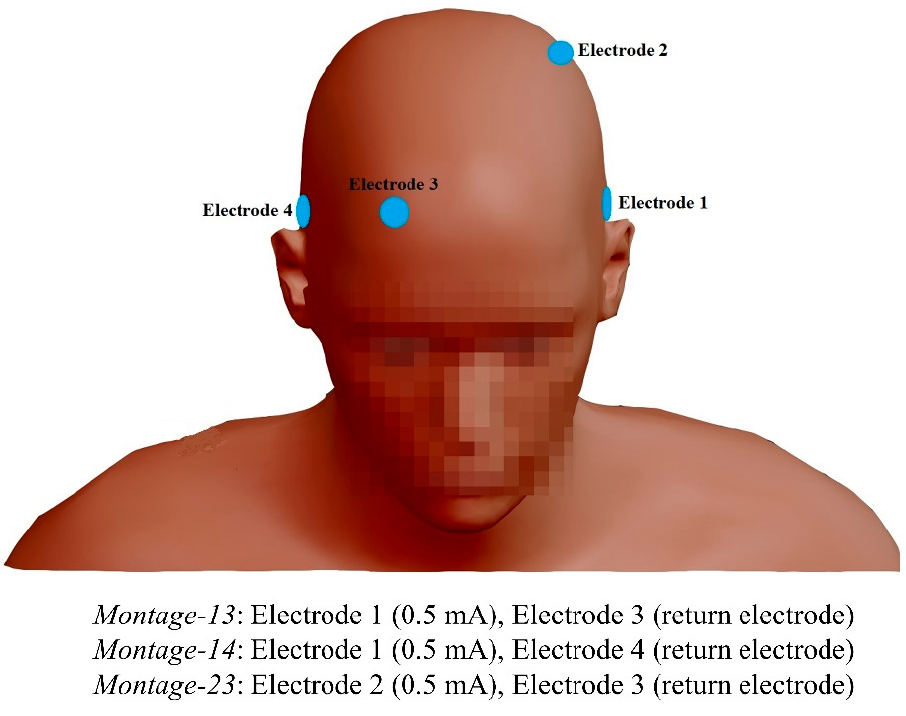
Figure 2. The positions of stimulation electrodes.